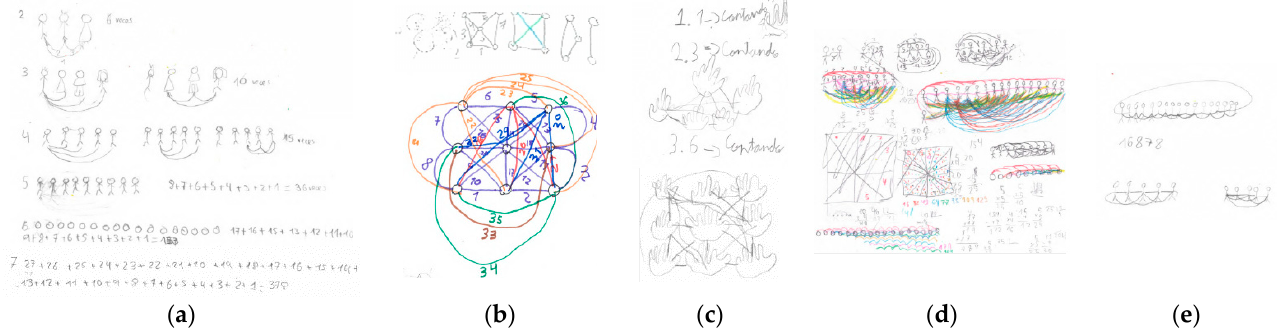
Figure 9. Counting strategies. Drawing made by participant: ( a ) A5; ( b ) A2; ( c ) A3; ( d ) A7; ( e ) A4.